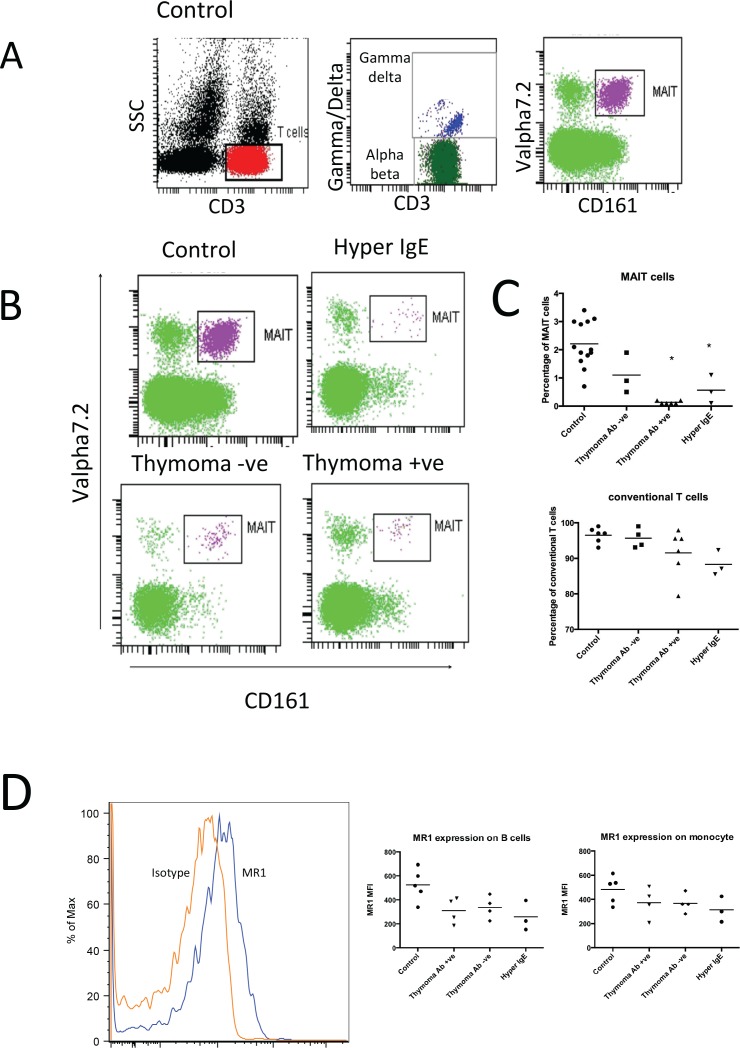
(A) MAIT identification strategy in a healthy control. MAIT cells were identified following sequential gating of CD3 and TCR αβ expression, prior to their Vα7.2 and CD161 co staining. (B) Representative MAIT enumeration from primary and secondary immunodeficiency groups. (C) Mean percentage of MAIT cells (Percentage of MAIT cells in αβ T cells) and conventional T cells (Percentage of conventional T cells in total T cells) present in controls (n = 16, range 1.3–3%), thymoma negative (n = 4, range 0.4–1.9%), thymoma positive (n = 6, range 0.1–0.2%), and HIES (n = 3, range 0.1–1.1%) patients. The percentages of MAIT cells were found to be significantly lower in thymoma positive and HIES patients compared to the healthy controls (*P<0.0001). (D) Representative MR1 expression on control B cell population. Level of MR1 expression on B cell population was not significantly different across the clinical groups.